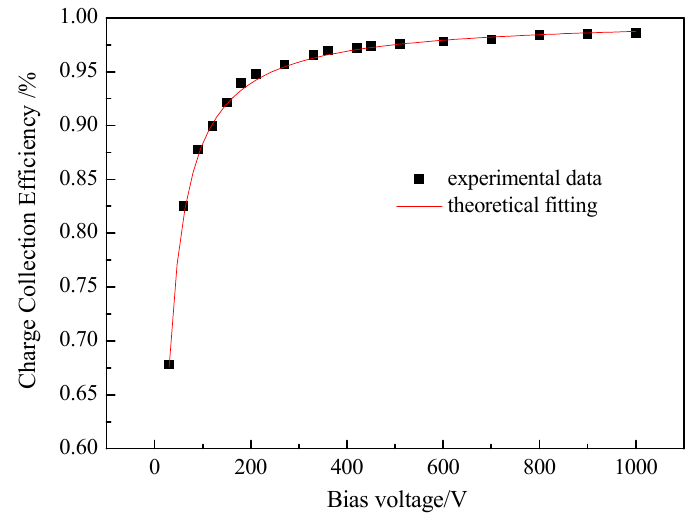
Figure 11. Collection efficiency of CMT:In detectors after Cd atmosphere annealing at 1073 K for 240 h and Te atmosphere re-annealing at 773 K for 120 h.